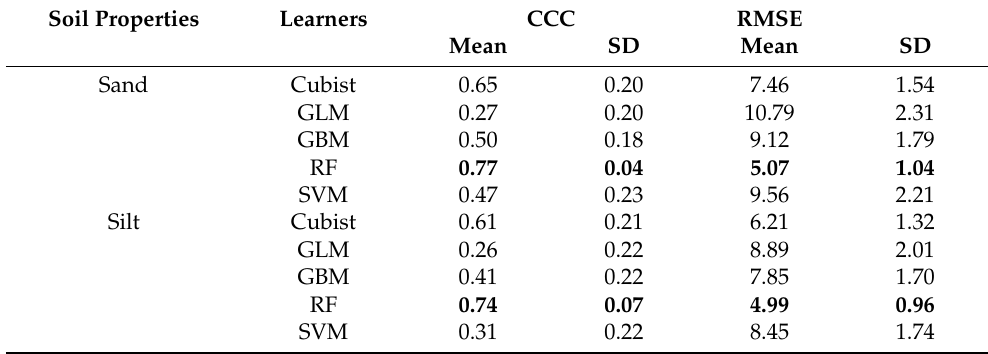
Table 4. Performance of base learners to predict soil properties based on 20 repeats, ten-fold cross